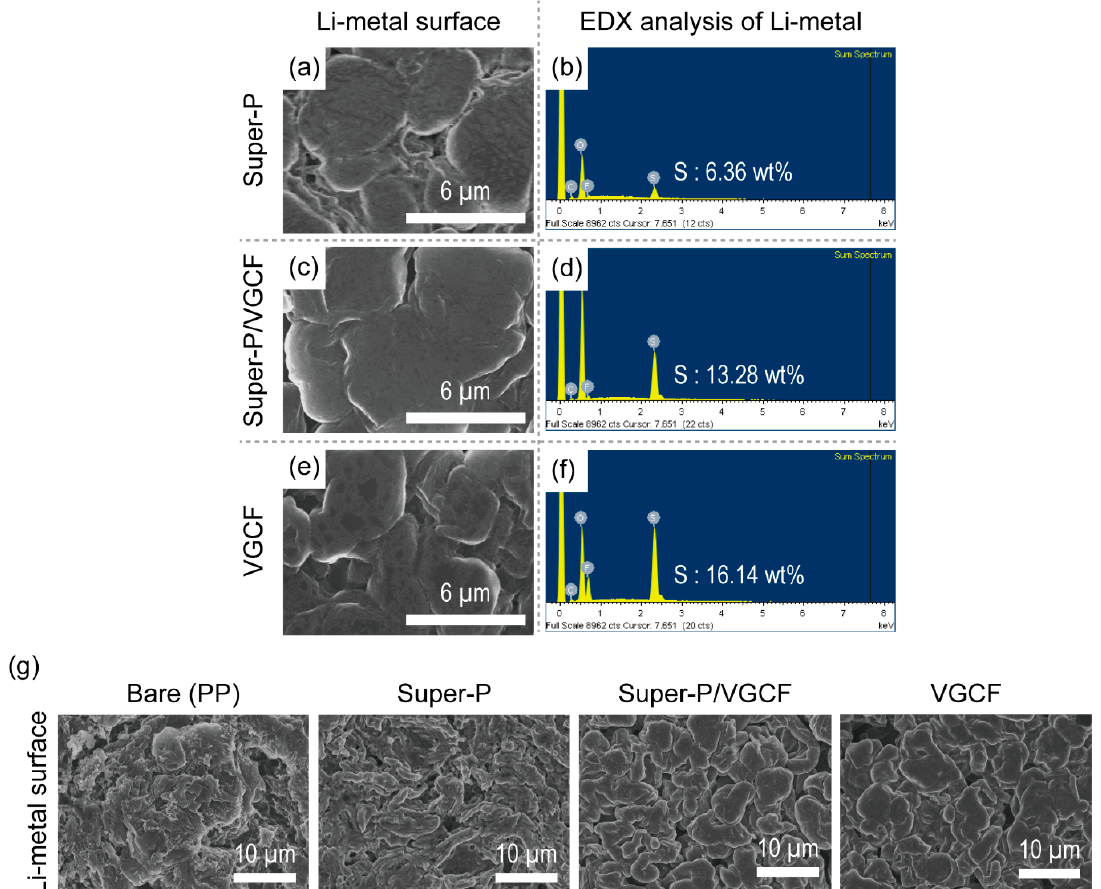
Figure 6. ( a , c , e ) SEM images and ( b , d , f ) EDX elemental analysis of the Li metal after 20 cycles (corresponding to Figure 3c); ( g ) SEM images of the Li metal after 50 cycles (corresponding to Figure 3c).